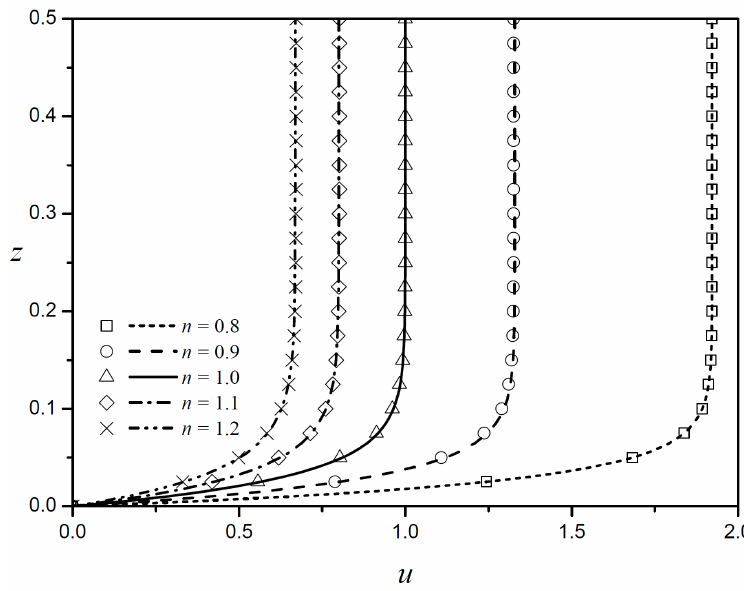
Figure 2. Velocity profiles obtained by Zhao et al. [15] against the present results for five different fluid behavior indices for L D = 0.03. Symbols, Zhao et al.; lines, present results.